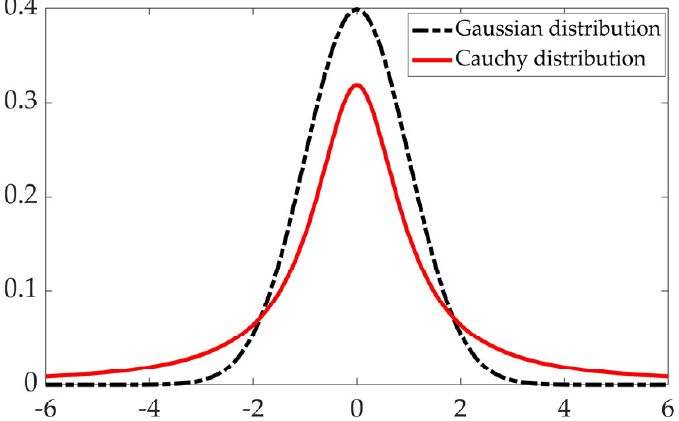
Figure 1. Comparison between Cauchy distribution and Gaussian distribution. The position update formula of the fusion map-compass operator and the